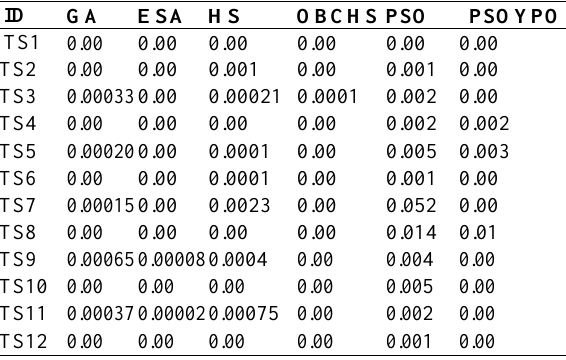
Table 5. Comparison of STD results for normal scale problems